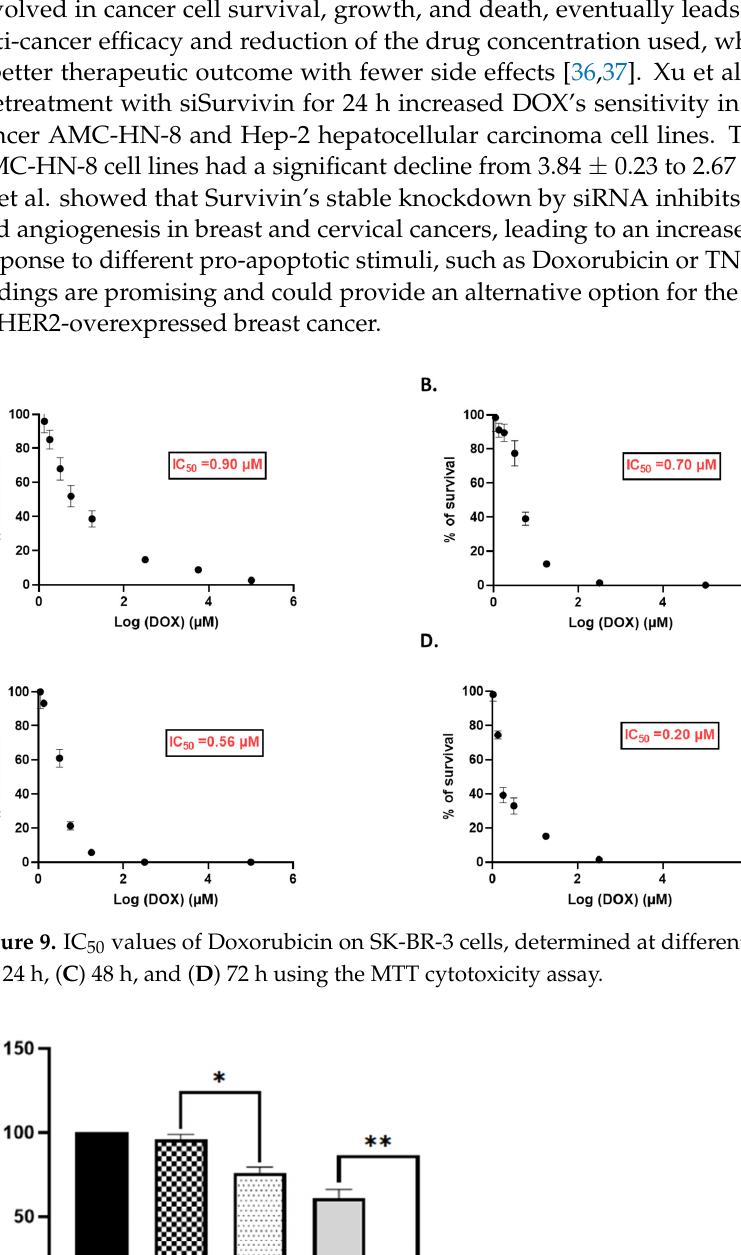
Figure 8. Cell viability of the SK-BR-3 cell line treated either with a mixture of control (Ctrl.) siRNA and TSF-SPIONs, a mixture of Ctrl. siRNA, poly-l-arginine (PLR), and chitosan, or TS-MSN ctrl. siRNA .